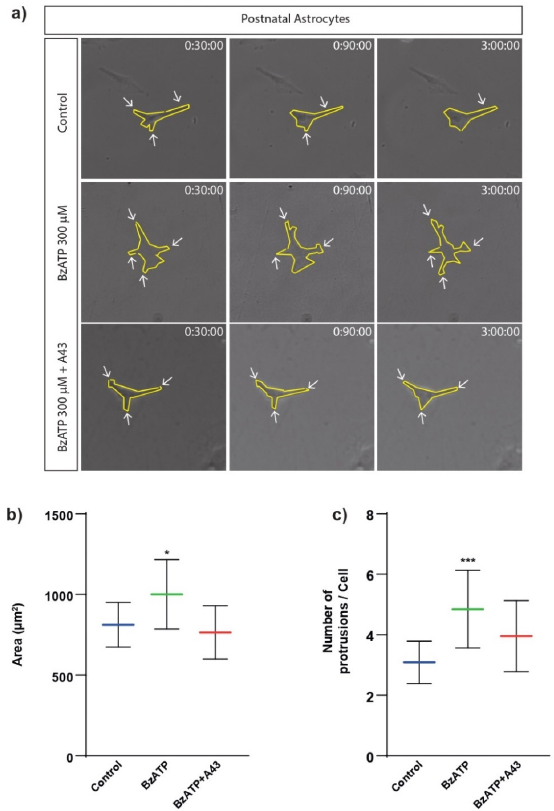
Figure 2. Effects of BzATP treatment on cell size and membrane protrusions of rat cerebellar as- trocytes. ( a ) Bright field images of astrocytes obtained after 3 h of time-lapse video microscopy. ( b ) Histogram showing the evolution of the cell size (area, in µ m 2 ), during a period of 3 h, in basal conditions or in the presence of 300 µ M BzATP. The effect of the P2X7 antagonist A43 is also in- cluded. In this case, astrocytes were preincubated with 10 µ M A43 for 5 min, prior to BzATP addition. ( c ) Histogram indicates the number of membrane protrusions present in astrocytic cells across the imaging experiment. Whiskers indicate standard deviation (SD); statistically significant differ- ences were calculated by employing a one-way ANOVA with Dunnett’s post-test and are indicated by * when p < 0.05 or *** p < 0.001. Experiments with only A43 are not considered for comparison because of the lack of visual evidence.